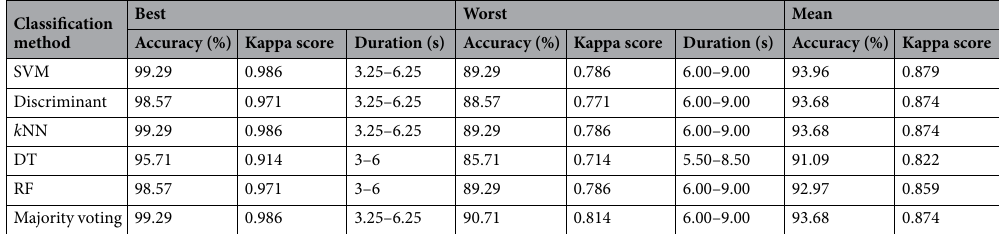
Table 8. Classification accuracy and kappa score results for three-second segments using Stockwell transform for datset II–III.